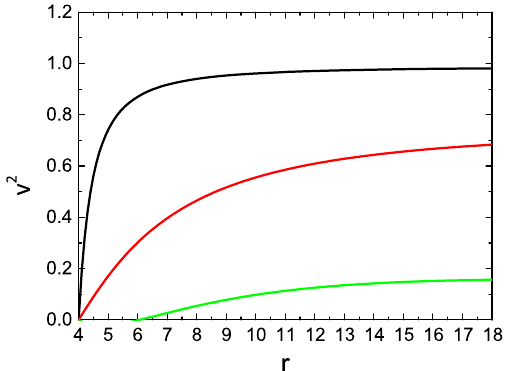
Fig. 3 (Squared) Speed v 2 (Eq. 45) of a uniformly accelerated particle outside the horizon of the AdS BH for α = 1; 0 . 2; 0 . 1 (black/red/green) ( M = 1, Λ = 0 . 01)